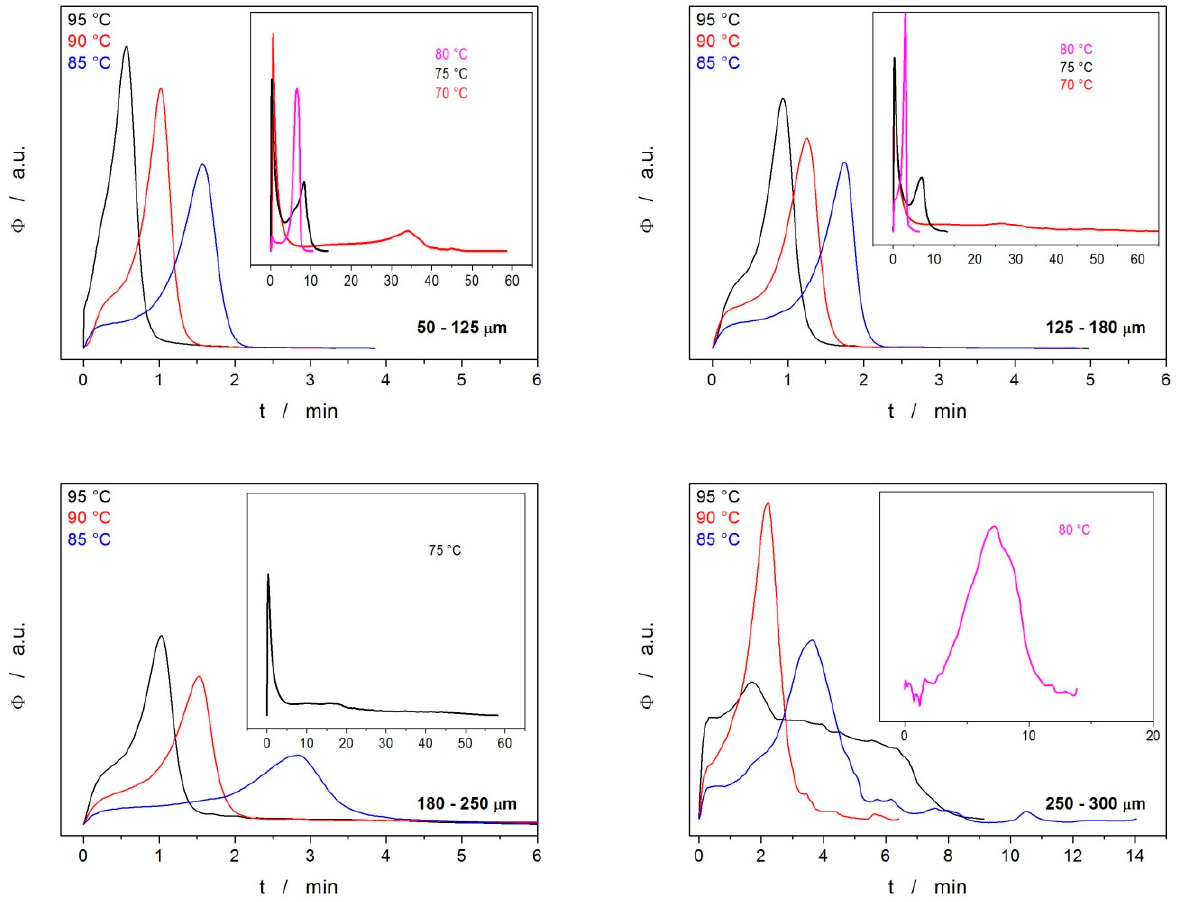
Figure 9. DSC curves for the isothermal crystallization experiments that exhibited detectable and reproducible signals—generally, fine powders annealed at higher temperatures. Exothermic signals evolve in the upwards direction.